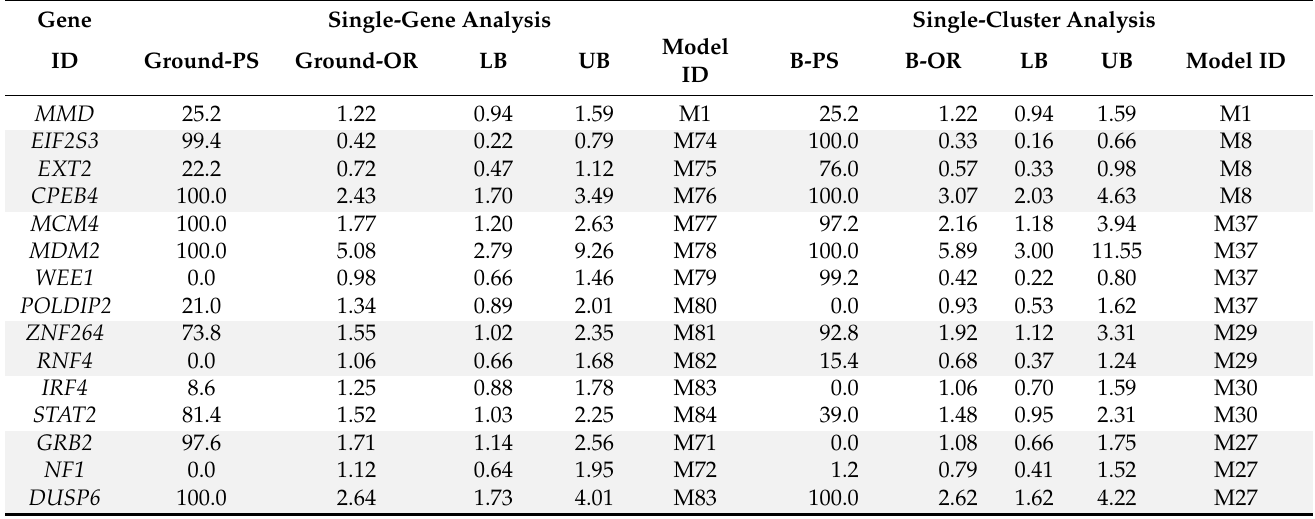
Table 3. Logistic analysis for single-gene and single-cluster models.